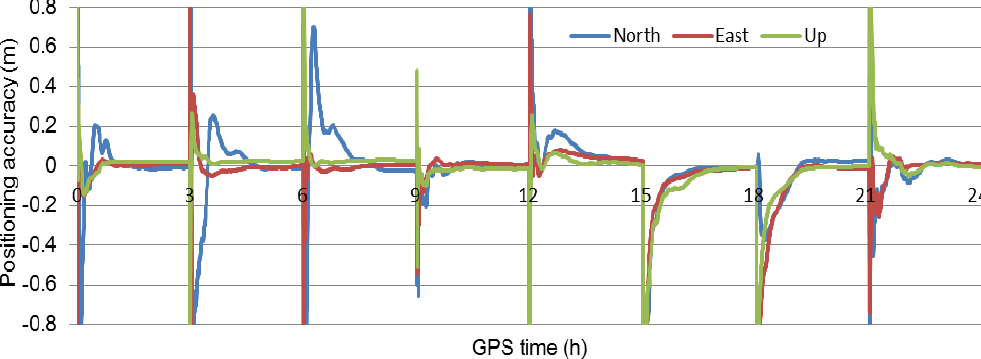
Figure 5. Positioning results of the user CMCJ for the eight 3-h sessions.